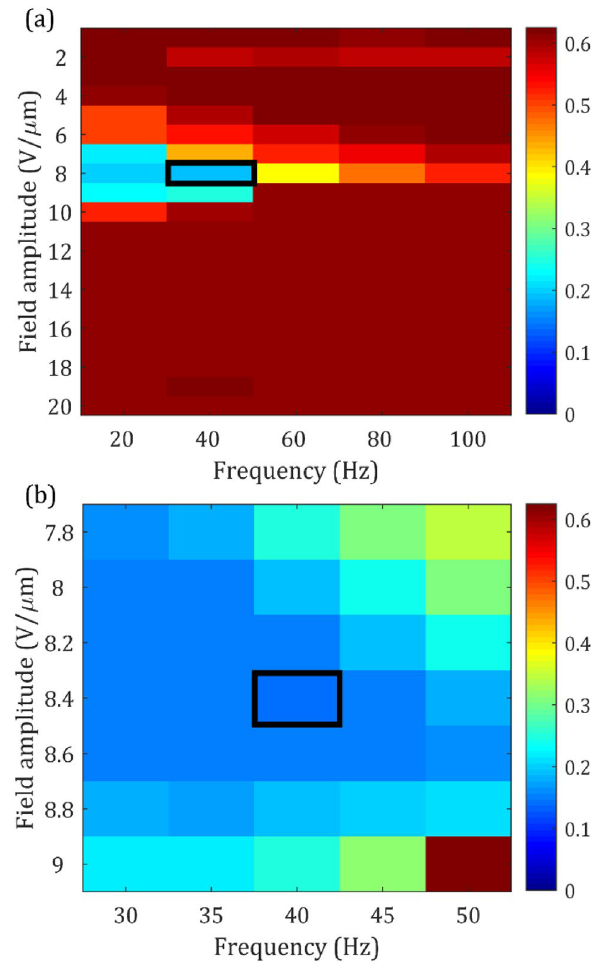
Figure 2. Colour maps showing the variation in the Speckle Contrast, C (legend shown on the secondary axis) for different amplitudes and frequencies of a square wave electric field applied to the chiral nematic LC device (E7 + 2.5 wt% BDH1281, pitch 517 nm). ( a ) Electric field and frequency increments of 2 Vµm −1 and 20 Hz, respectively. ( b ) higher resolution measurements–electric field and frequency increments of 0.2 Vµm −1 and 5 Hz, respectively. The black boxes in ( a ) and ( b ) represent the electric fields corresponding to the smallest speckle contrast ratio, C (maximum speckle reduction). All measurements were carried out at 25 °C using a 20 µm-thick